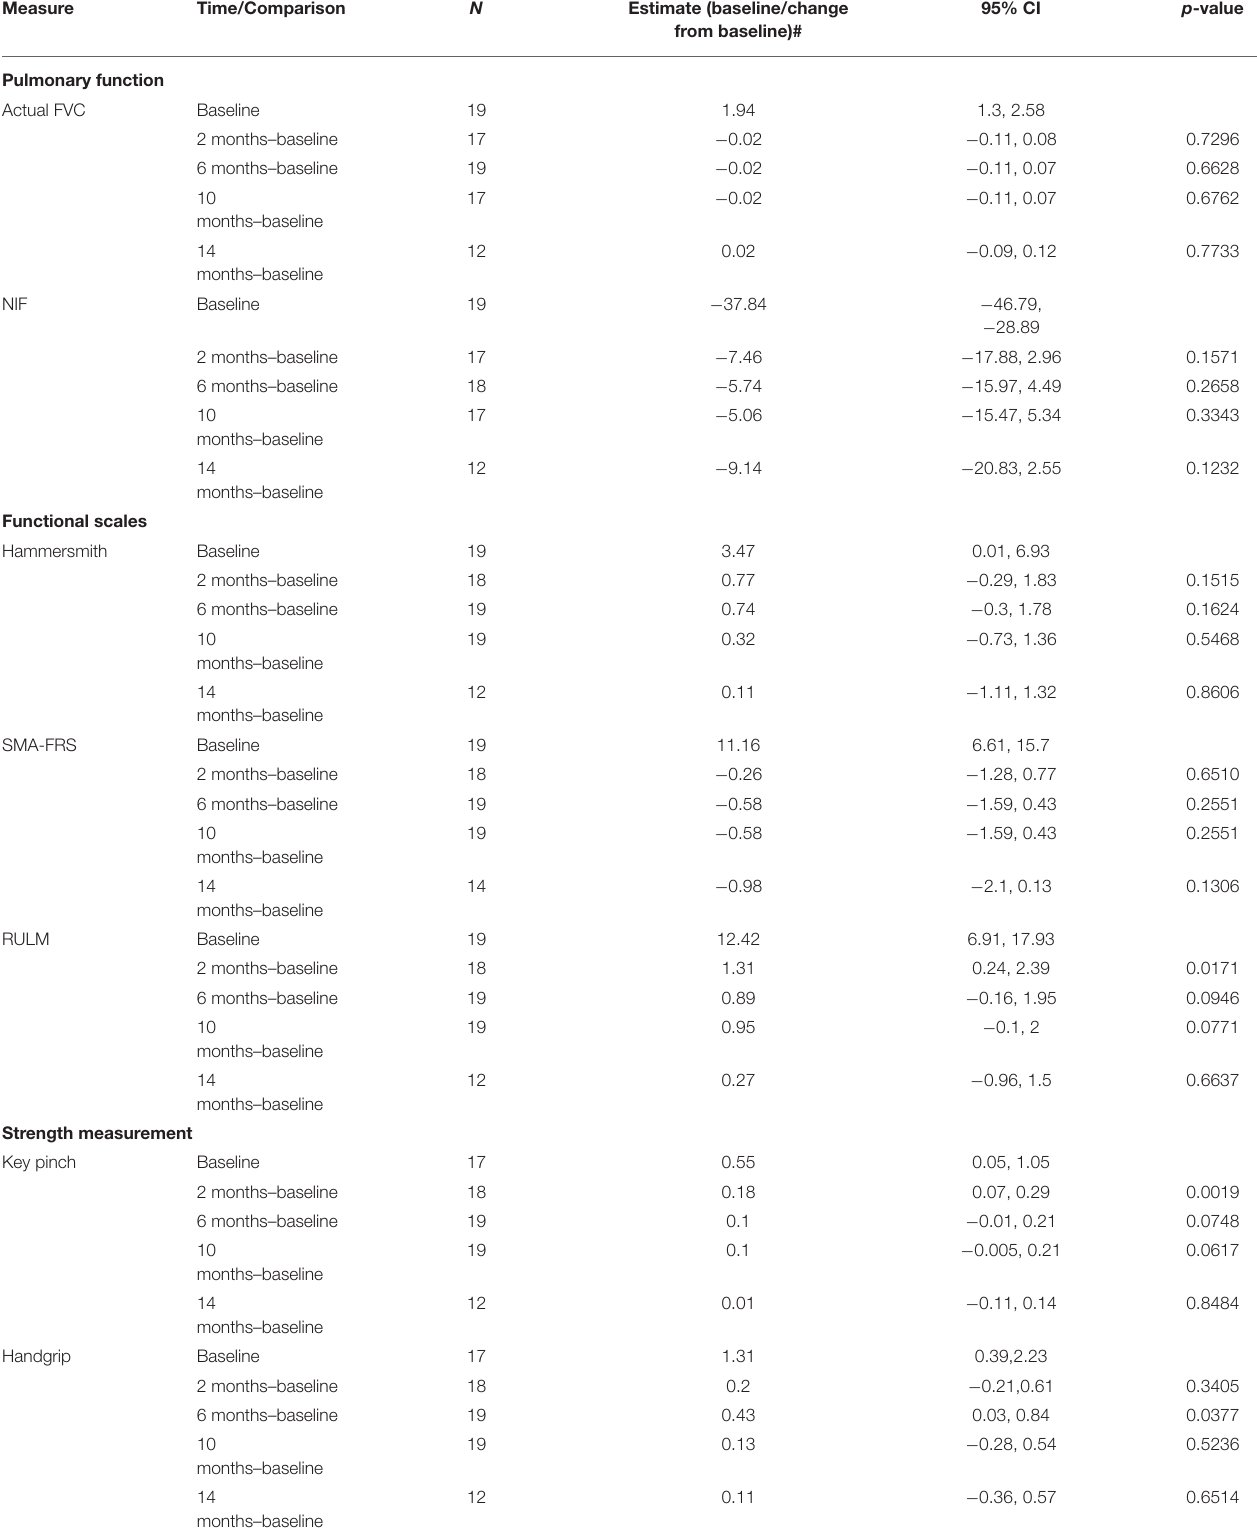
TABLE 4 | Longitudinal change of outcomes.